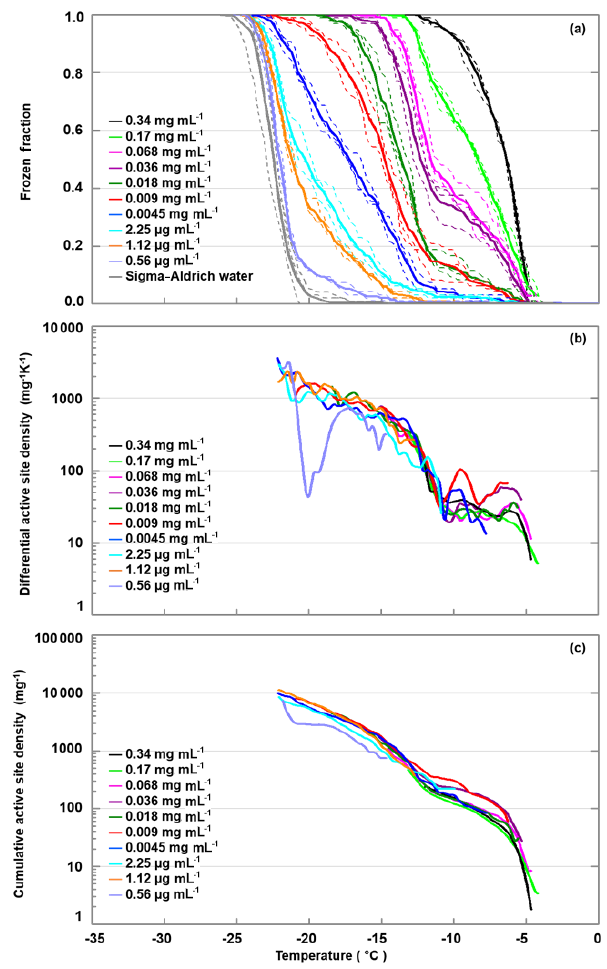
Figure 6. Freezing experiments with an apoferritin (batch 2) dilu- tion series. (a) Fraction of droplets frozen as a function of tempera- ture for concentrations between 0.34mgmL − 1 and 0.56µgmL − 1 . (b) Differential IN-active site densities per unit mass and kelvin cal- culated with Eq. (2). (c) Cumulative active site densities per unit mass calculated with Eq.